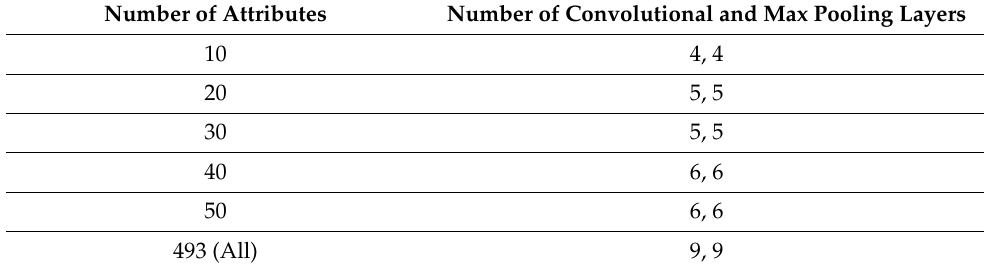
Table 2. 1-D CNN architecture according to the size of the input. (Illustrations by the authors).